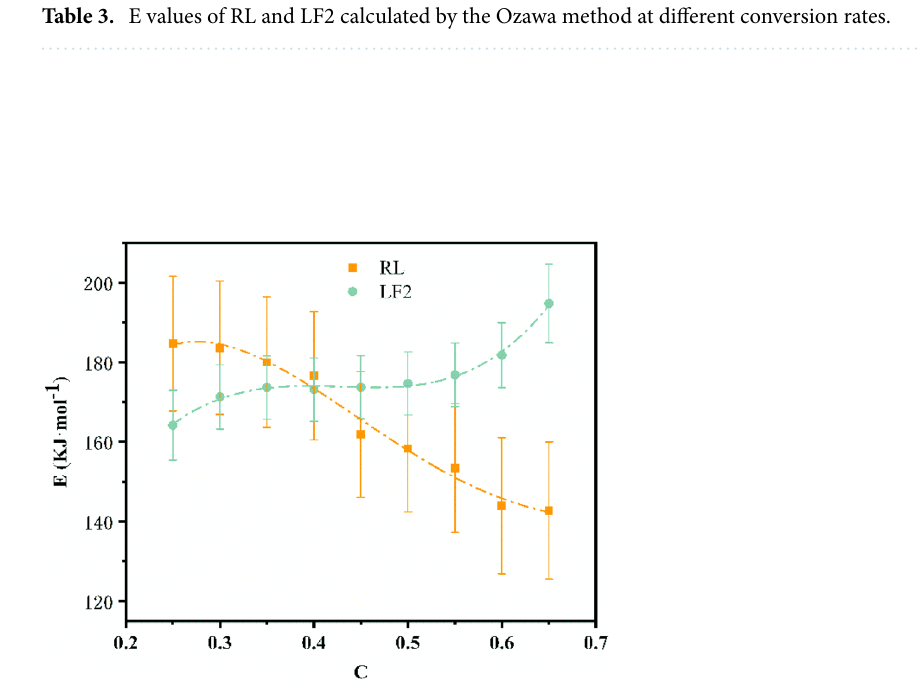
Figure 7. E of RL and LF2 calculated by the Ozawa method at different conversion